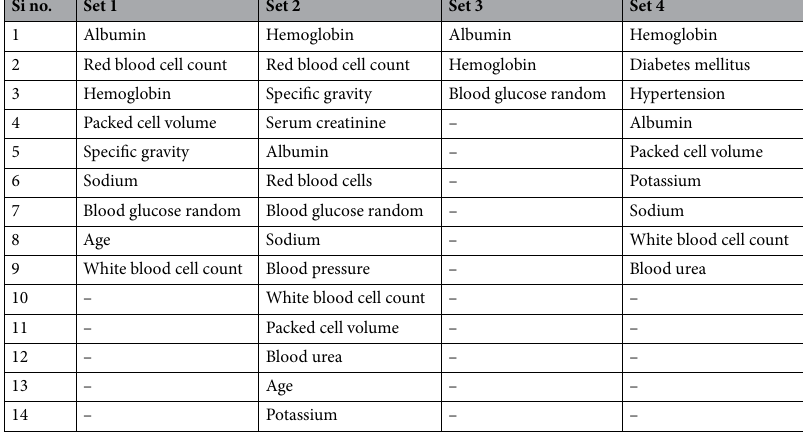
Table 8. XGBoost features importance on all four subsets.